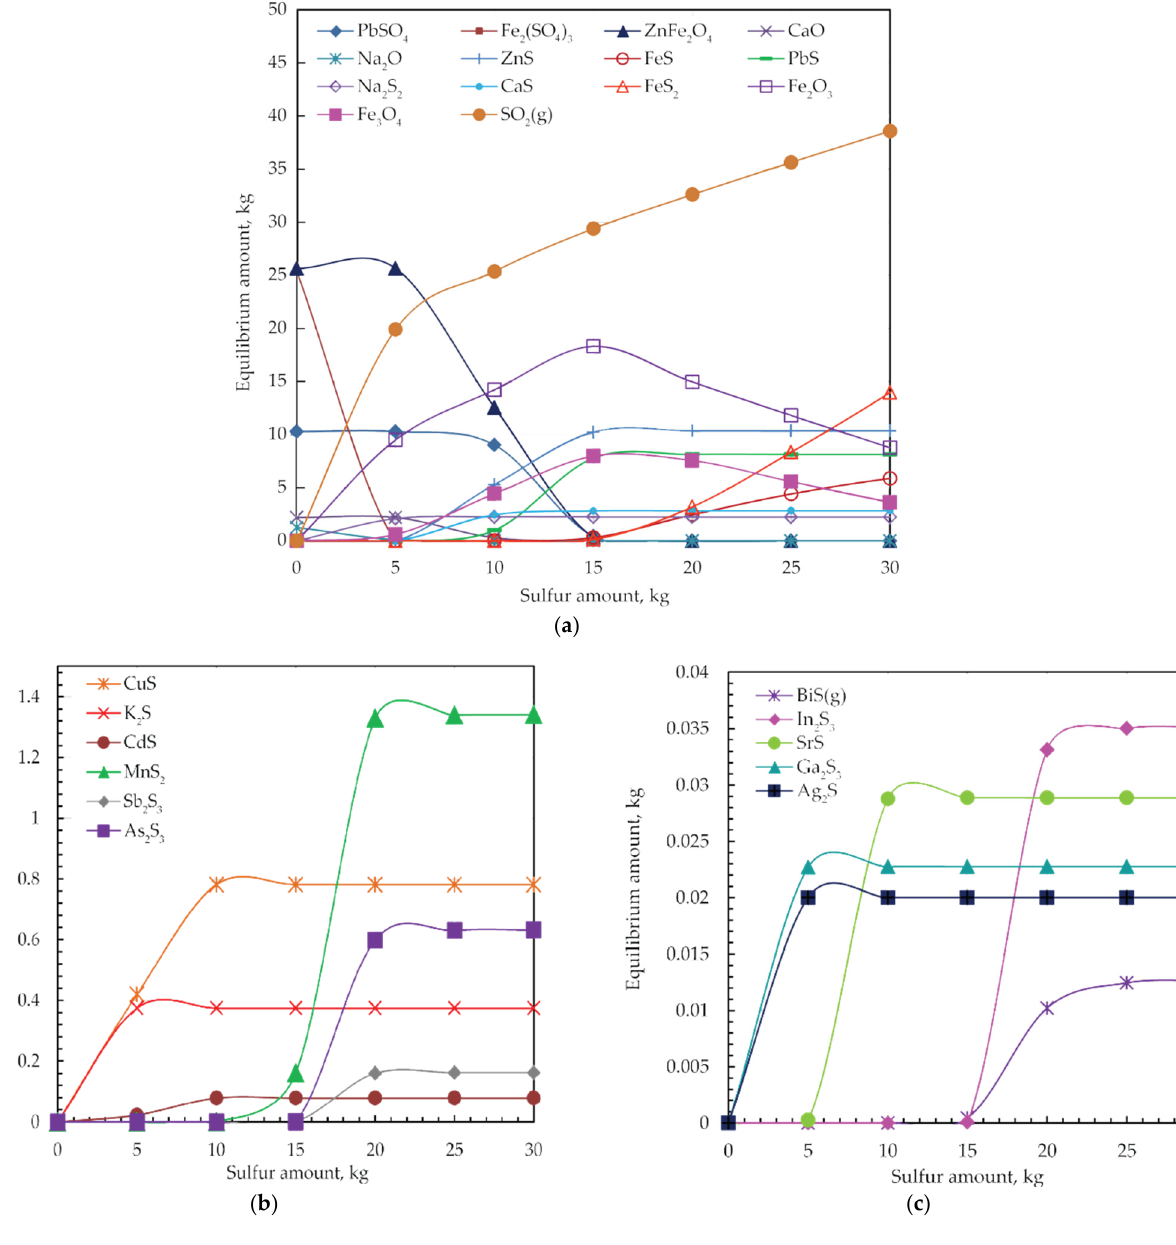
Figure 8. Equilibrium phase diagrams of ( a ) main and ( b , c ) minor products of jarosite-PbAg sludge reaction with different sulfur amounts at 550 °C.